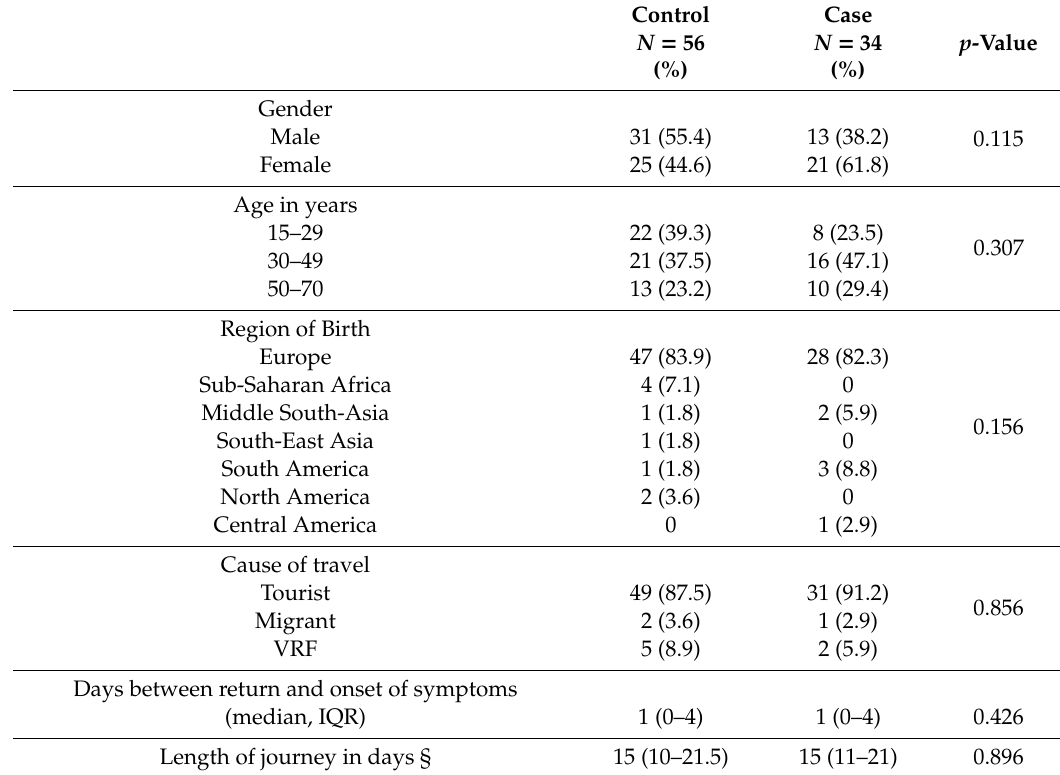
Table 1. Clinical and demographic characteristics of cases: Chikungunya (CHIKV), Dengue (DENV), and Zika (ZIKV) infection cases, and controls